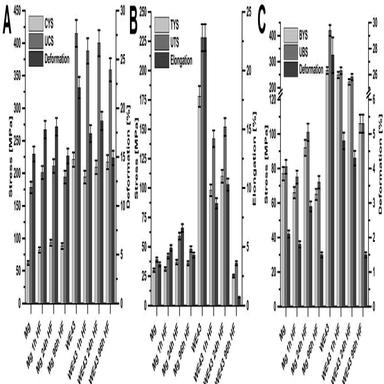
Fractography with EDS analysis of A) bare Mg, B) bare WE43, C) Mg-24h HF and D) WE43 24h HF.